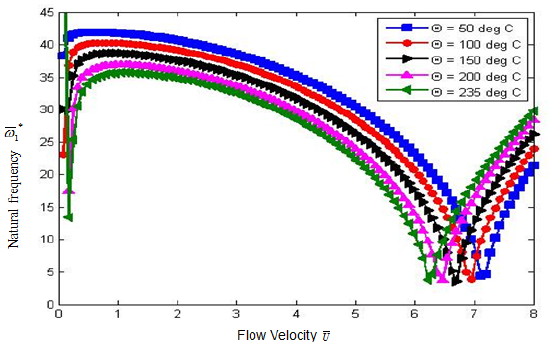
Figure 10. Absolute values of the transverse natural frequencies ¯ ω 1 ∗ profile for the case R i = 0 . 41 m,L = 2 km,n = 1 ,δ ¯¯ ω ∗ 1 0 . 3721 , Θ = 100 ◦ C,χ = − 0 . 2